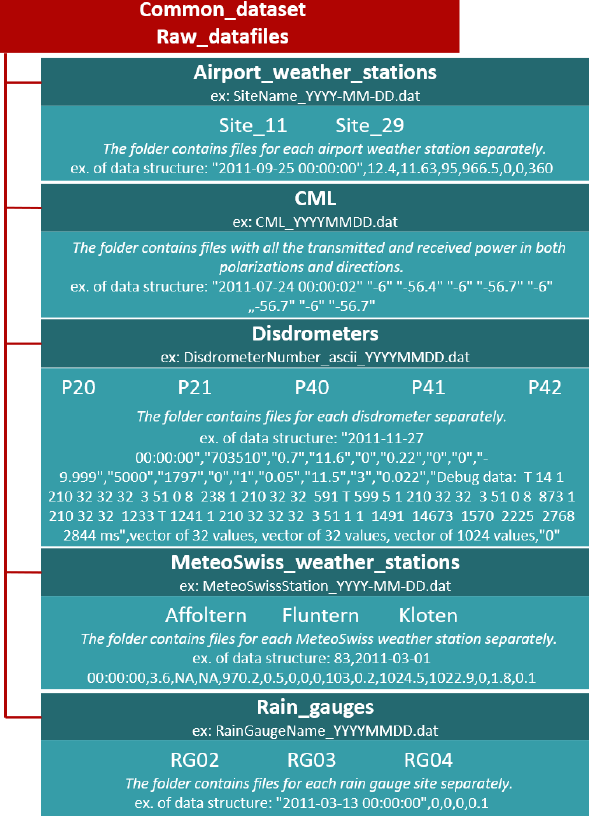
Table 4 summarizes the daily plots of measured quantities. All plotted quantities are accompanied by a plot of missing values. Each column in those figures represents 1 h of the day. The proportional amount of missing values in each hour is displayed in red.